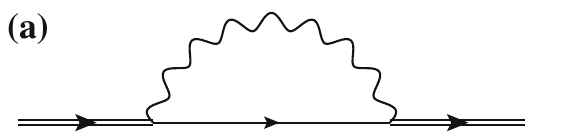
a composite neutrino: forward arrows correspond to the (cid:8) N ∗ ¯ N ∗ (cid:9) con- traction, whereas forward–backward arrows to (cid:8) N ∗ N ∗ (cid:9) and (cid:8) ¯ N ∗ ¯ N ∗ (cid:9) , the latter being typical of a Majorana fermion